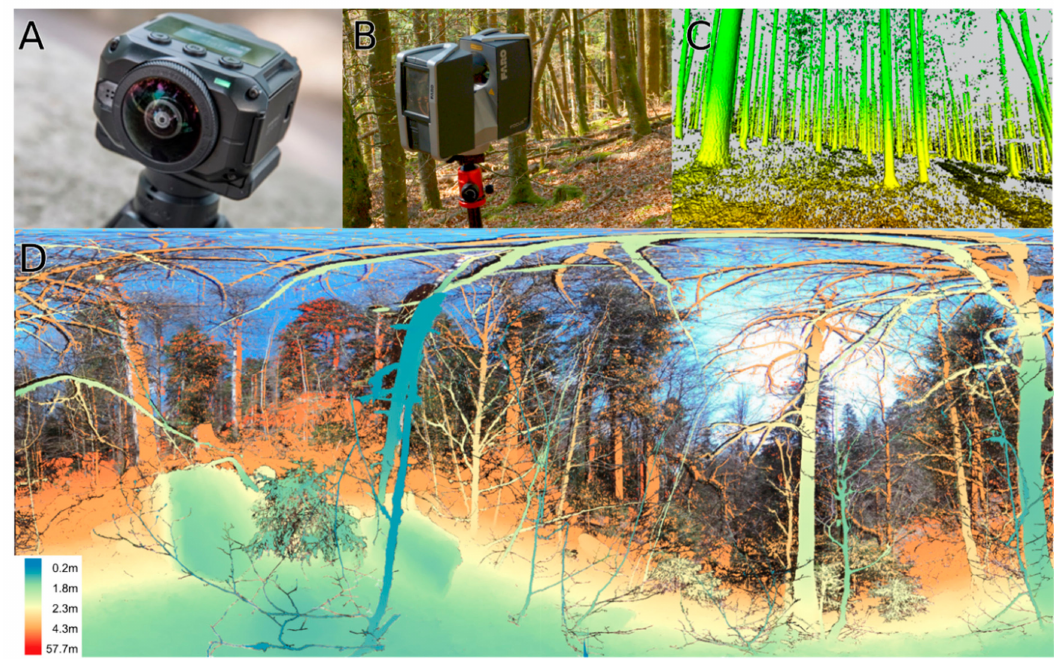
Figure 3. ( A ): Garmin VIRB 360 digital camera; ( B ) Faro Focus 120 terrestrial laser scanner; ( C ): Visualization of a point cloud; ( D ): overlay of the 360 ◦ -image from the camera with the distance image from the scanner—blue colors indicate closer red colors more distant